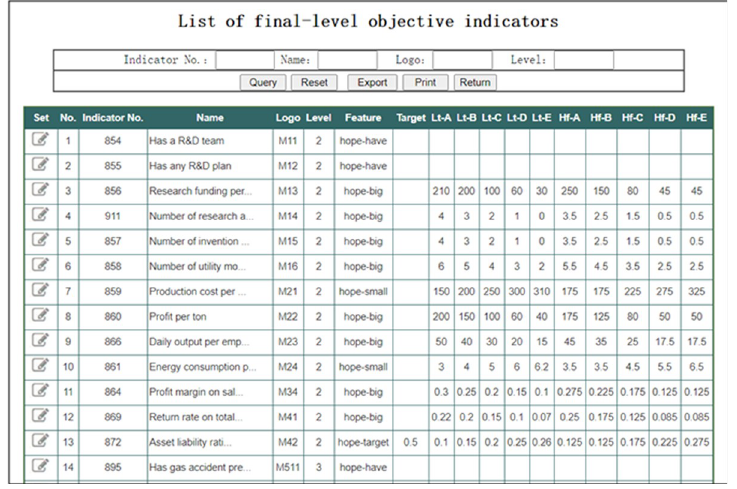
Fig 10. List of final-level objective indicators.